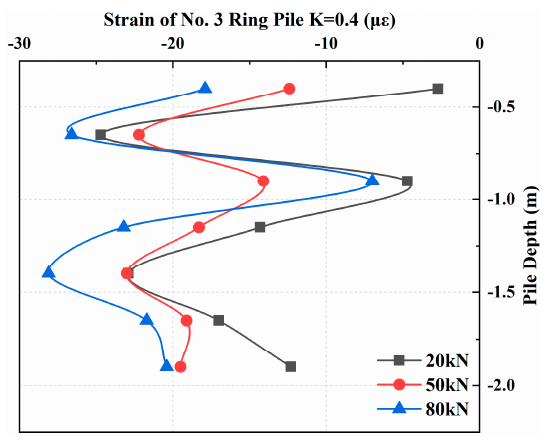
Figure 12. Pile strain of Solid Pile No. 2.